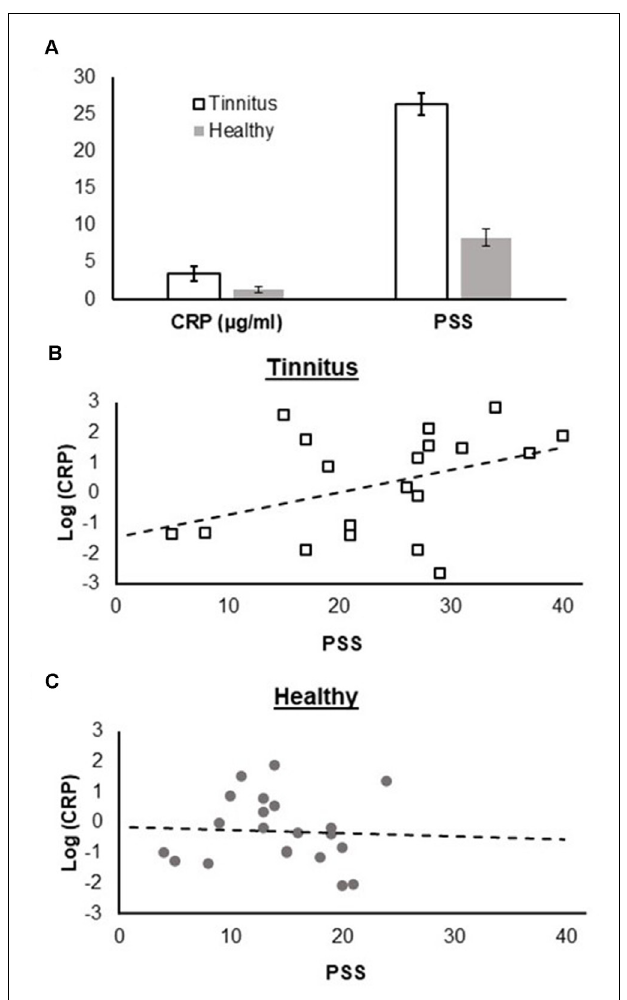
FIGURE 1 | (A) Comparison of C-reactive protein (CRP) levels and Perceived Stress Scale (PSS) scores between tinnitus patients and healthy controls, (B) association between CRP levels and PSS scores in the tinnitus group, and (C) in the control group. CRP levels and PSS scores are scaled in the same way for both groups and panels (B) and (C) are directly comparable.